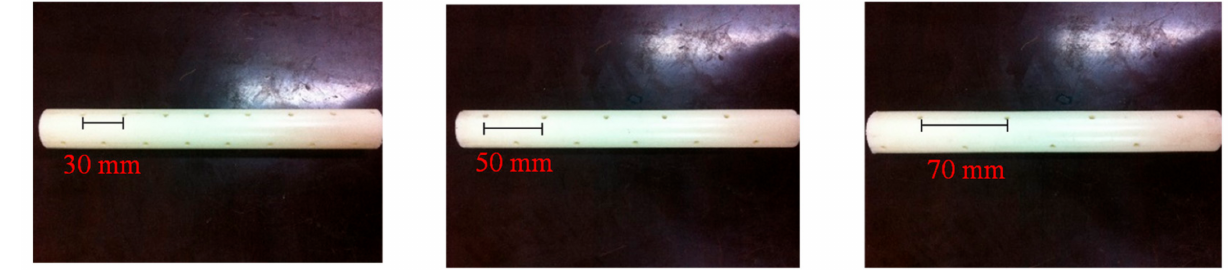
Figure 3. Screen pipes with different sieve opening